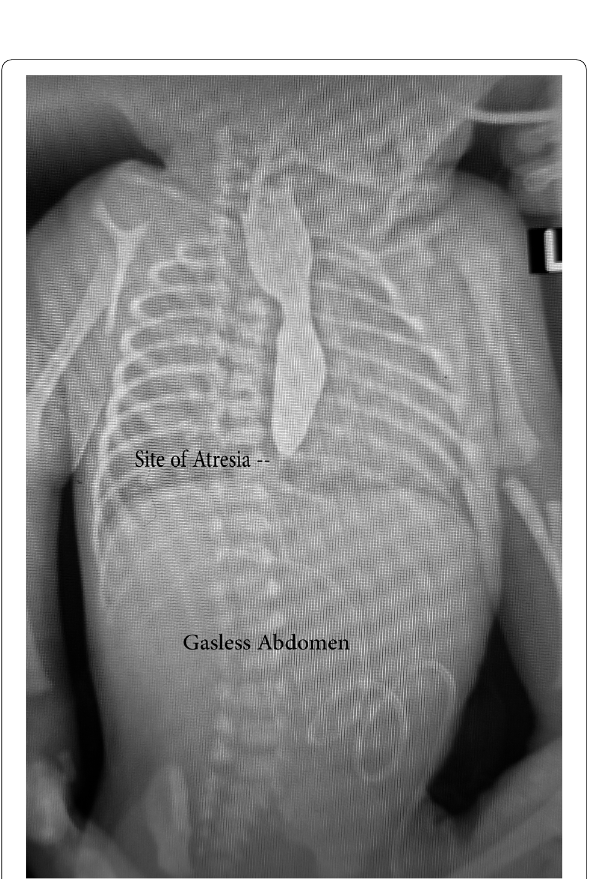
Fig. 3 Upper GIT contrast study showing the blind-ending